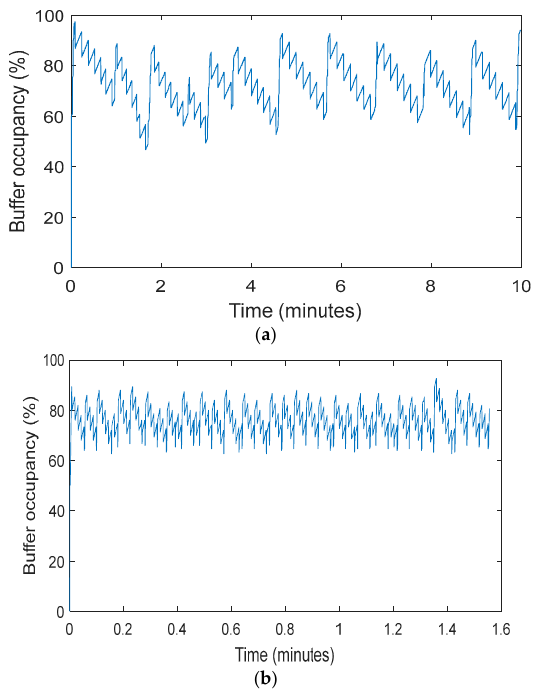
Figure 9. ( a ) Buffer occupancy with IVSP when β = 0.25; ( b ) buffer occupancy with IVSP when β = 0.5.